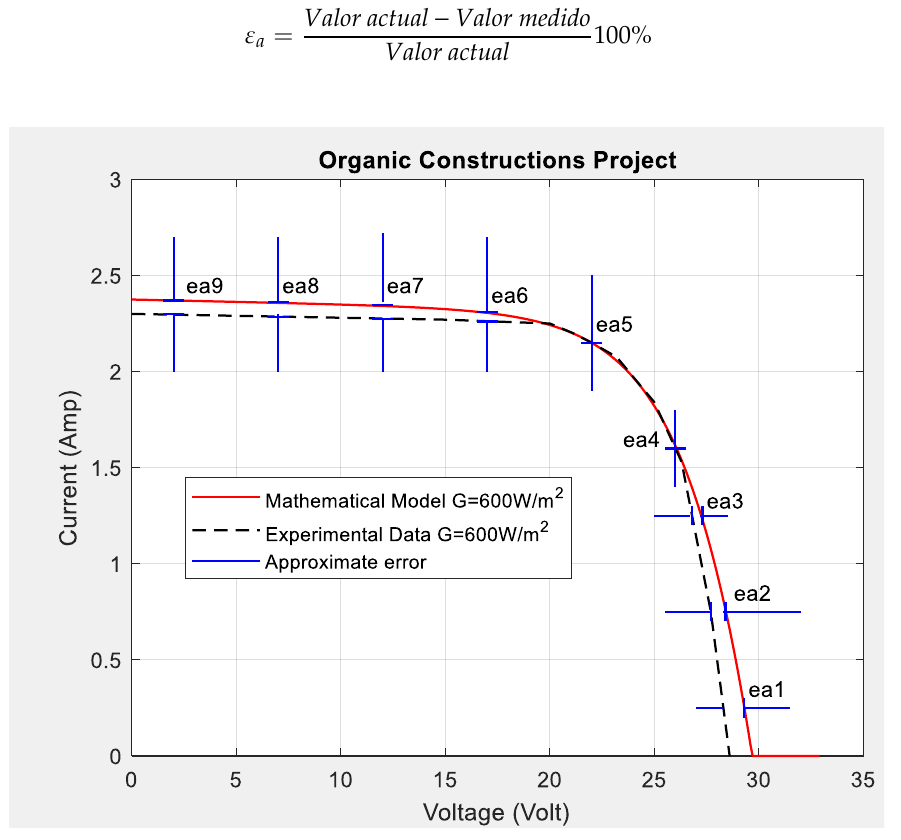
Figure 23. Referential graph for the estimation of errors between the mathematical model and the experimental curve of the PV system.